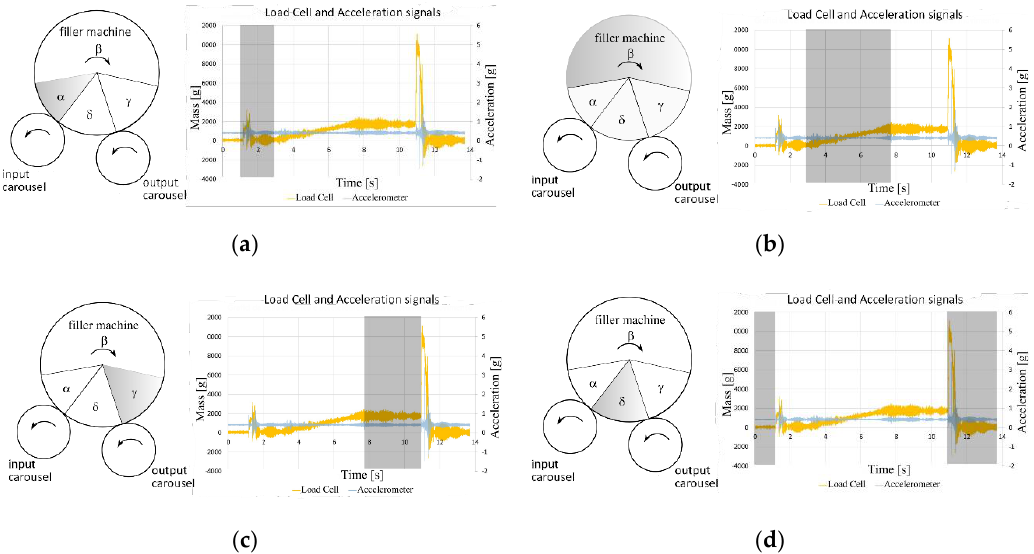
Figure 2. Schematic representation of the filling phases and related acceleration (light-blue) and weight signals (yellow) behaviors. ( a ) Tare weight measurement; ( b ) Filling; ( c ) Final weighing; ( d ) Zero condition reset.